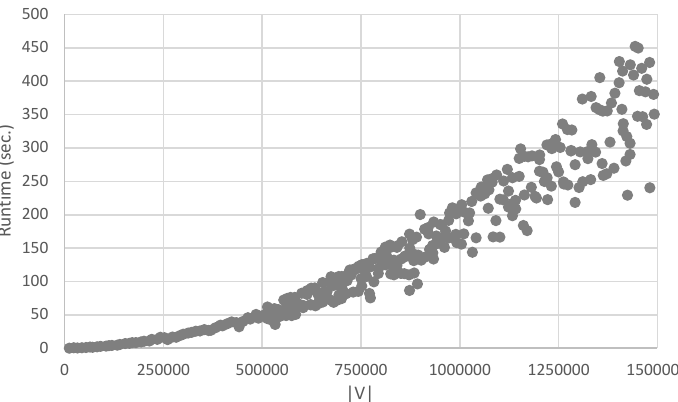
Figure 2. Runtimes for calculating regular equivalences.